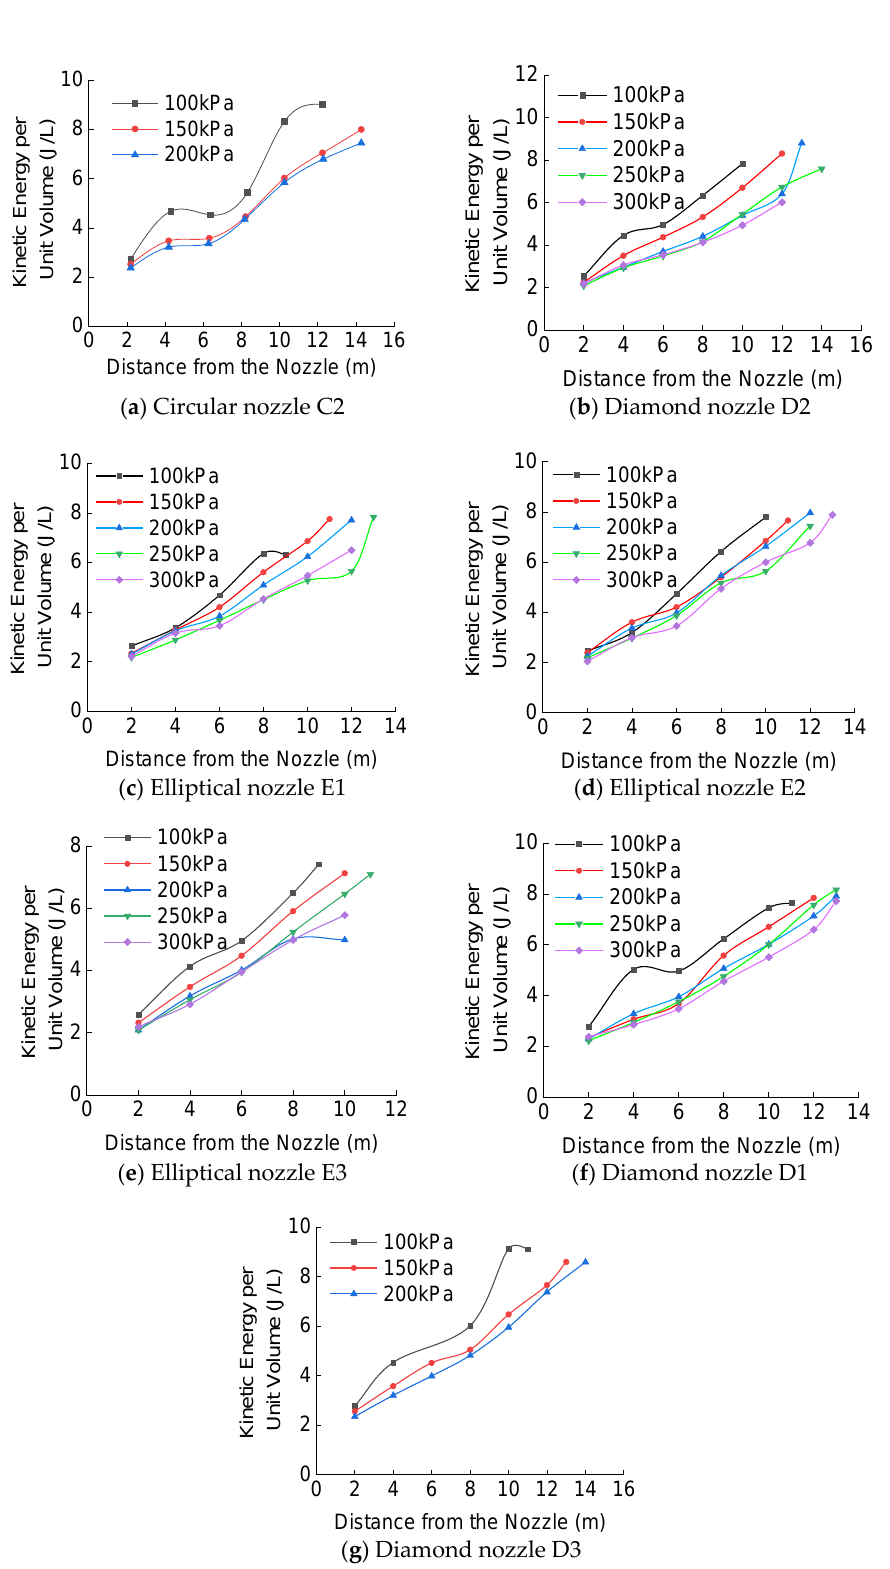
Figure 17. Kinetic energy per unit volume as a function of the distance from each nozzle under different working pressure levels. (C2 refers to the circular nozzle with a diameter of 5 mm; D1, D2, and D3 refer to the diamond nozzles with aspect ratios of 1.54, 1.32, and 1.11, respectively; E1, E2, and E3 refer to the elliptic nozzles with aspect ratios of 1.43, 2, and 2.58,